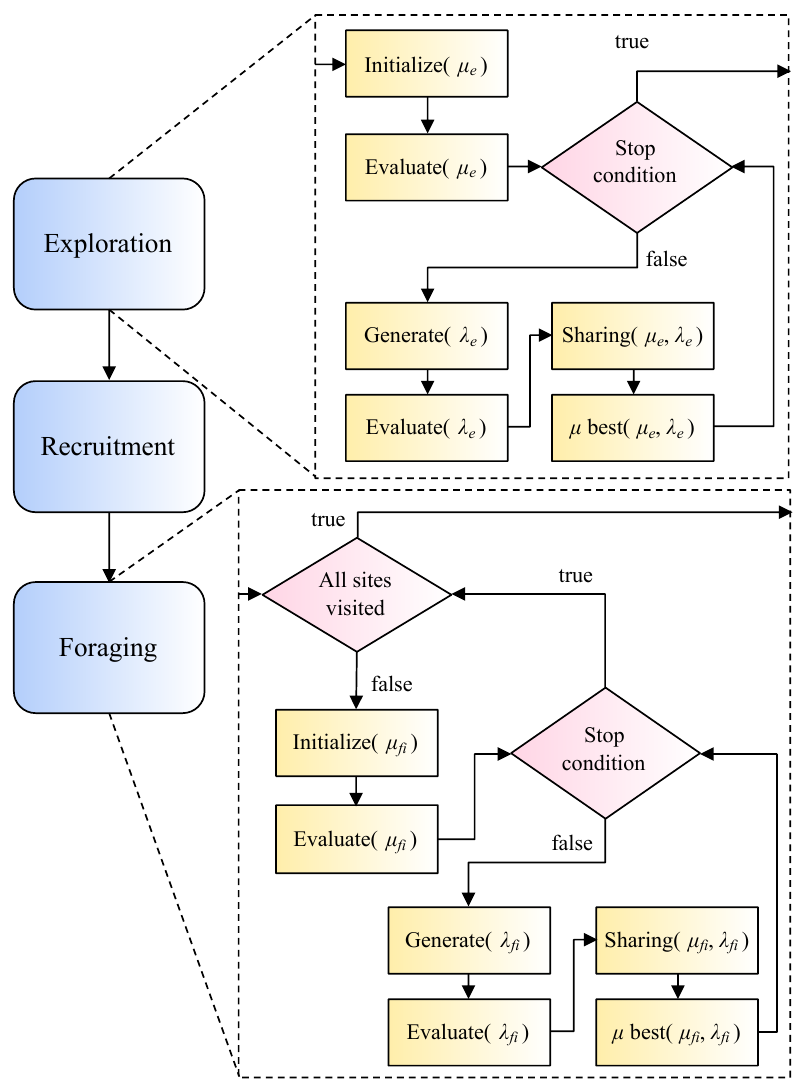
Figure 1. HSA has three main phases: exploration, recruitment, and foraging. The exploration and for- aging phases are based on the canonical ( µ + λ ) -ES but implement different evolutionary